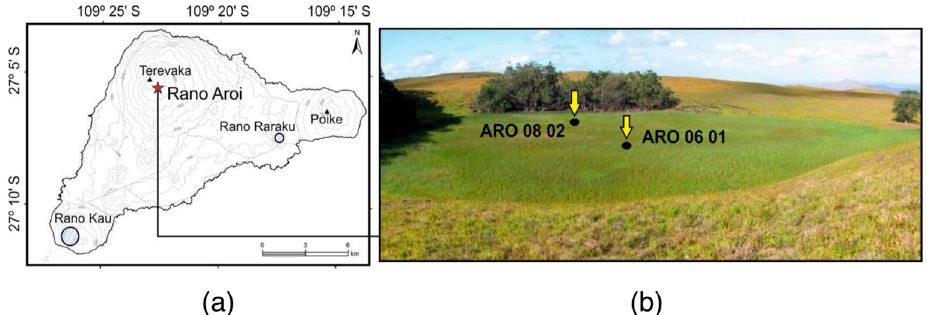
Figure 1. ( a ) Map showing the location of Rano Aroi on the island. ( b ) Photo of the Rano Aroi mire, indicating the location of the studied cores (ARO 06 01, center of the mire and ARO 08 02, margins of the mire).